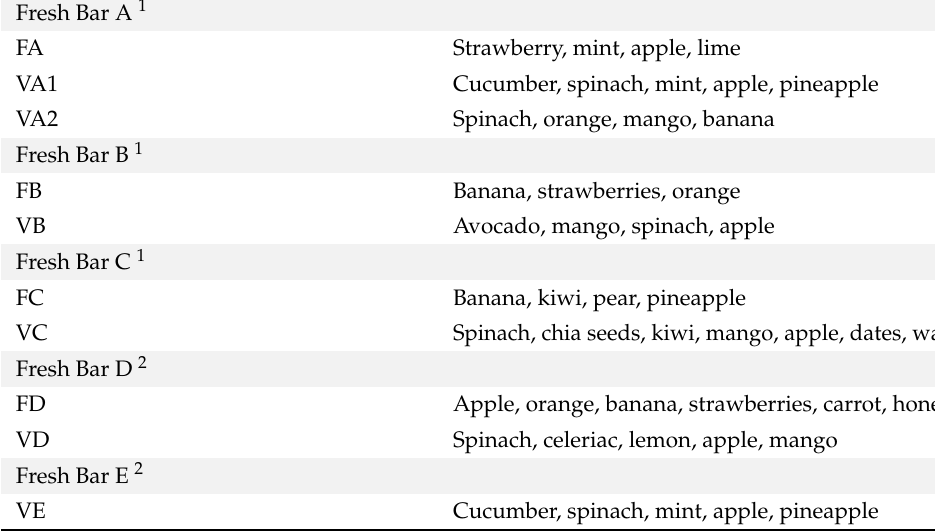
Table 1. Smoothie drink samples and their